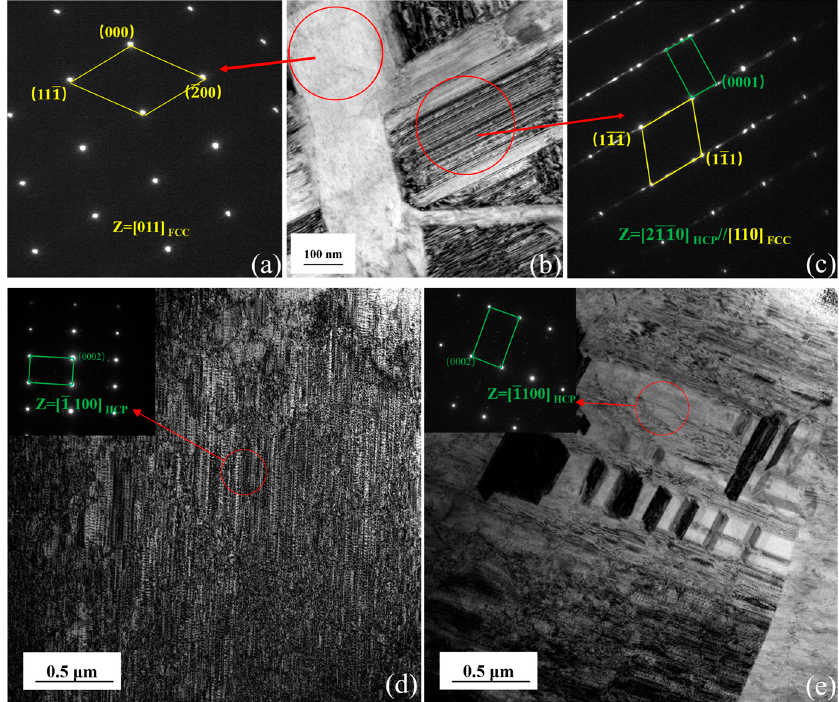
Figure 6. Bright-field TEM images and their corresponding SAED patterns. UT ( a – c ); 1T ( d , e ).